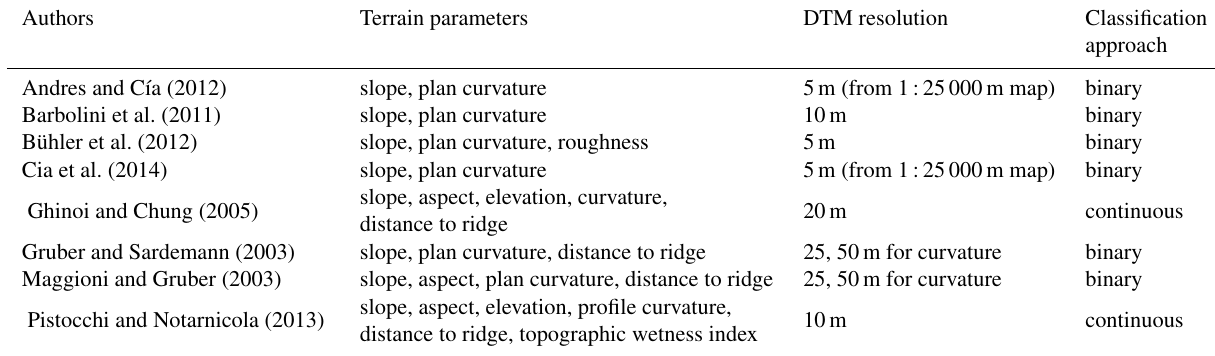
Table 1. Terrain parameters, DTM resolution and classification approach of algorithms for release area